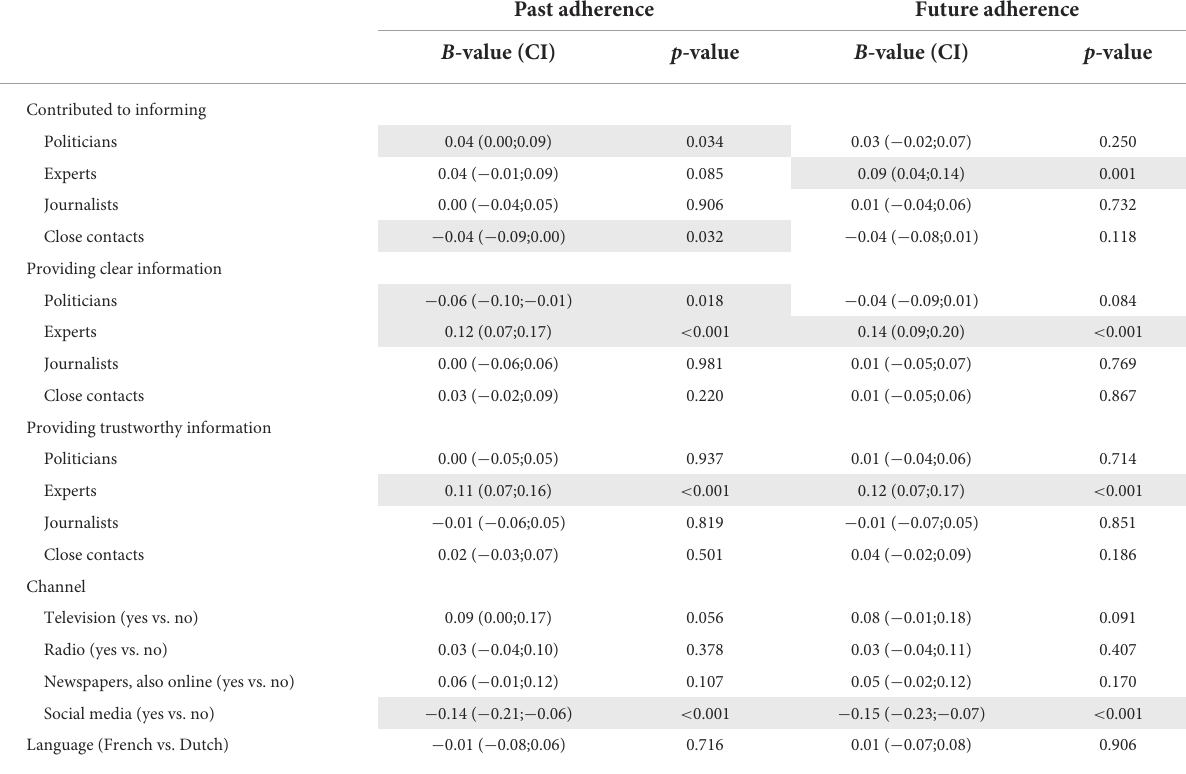
TABLE 2 Perception of information sources and use of channels associated with past and future adherence to IPC